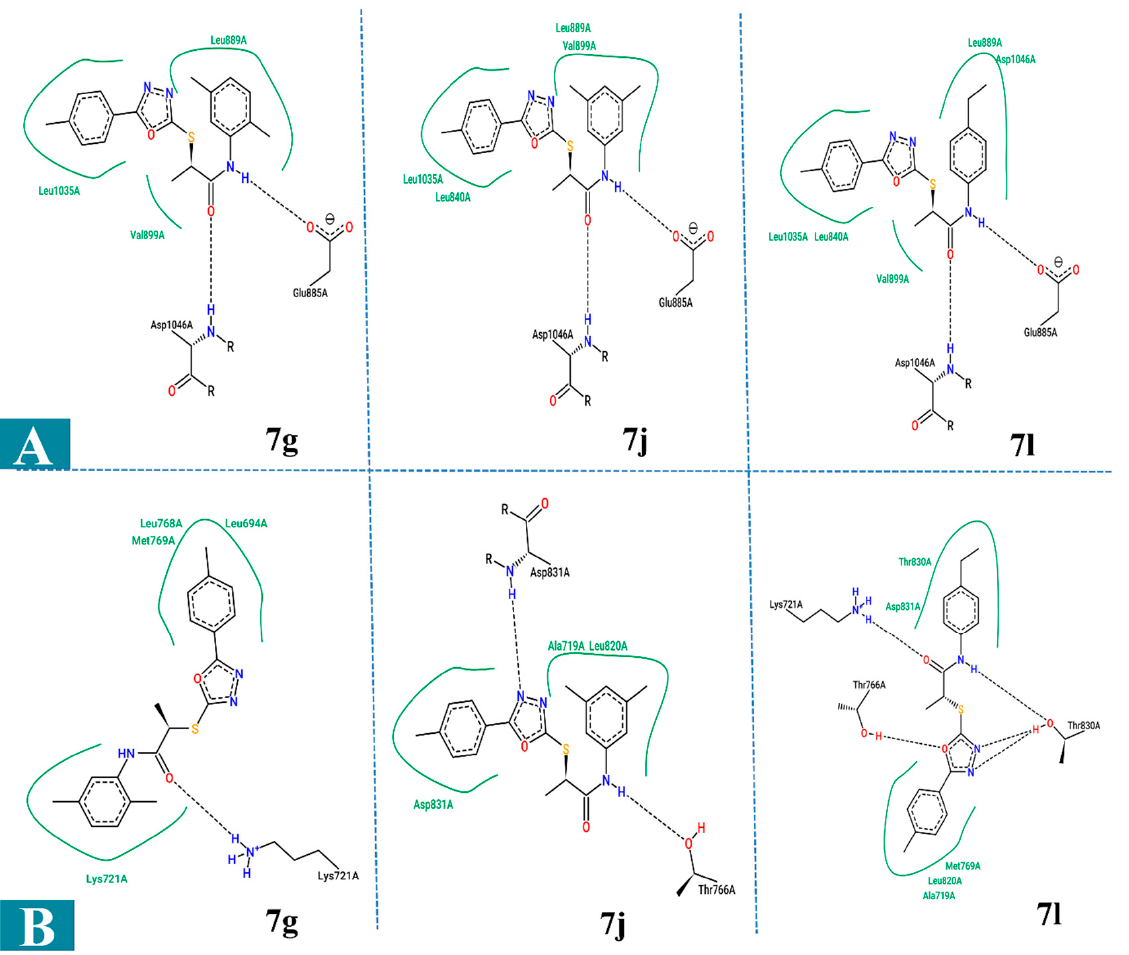
Figure 6. 2D binding interactions of 7g , 7j and 7l in best conformation with ( A ): VEGFR2 and ( B ): EGFR.